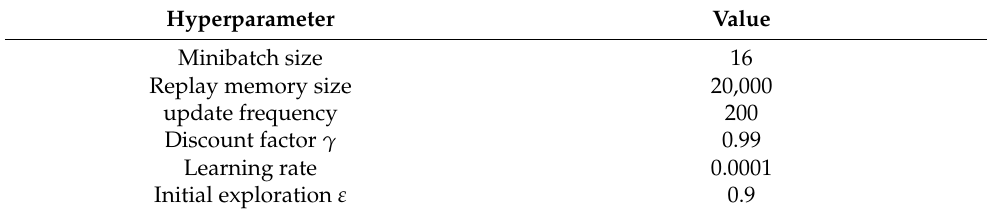
Table 2. List of hyperparameters and their values.